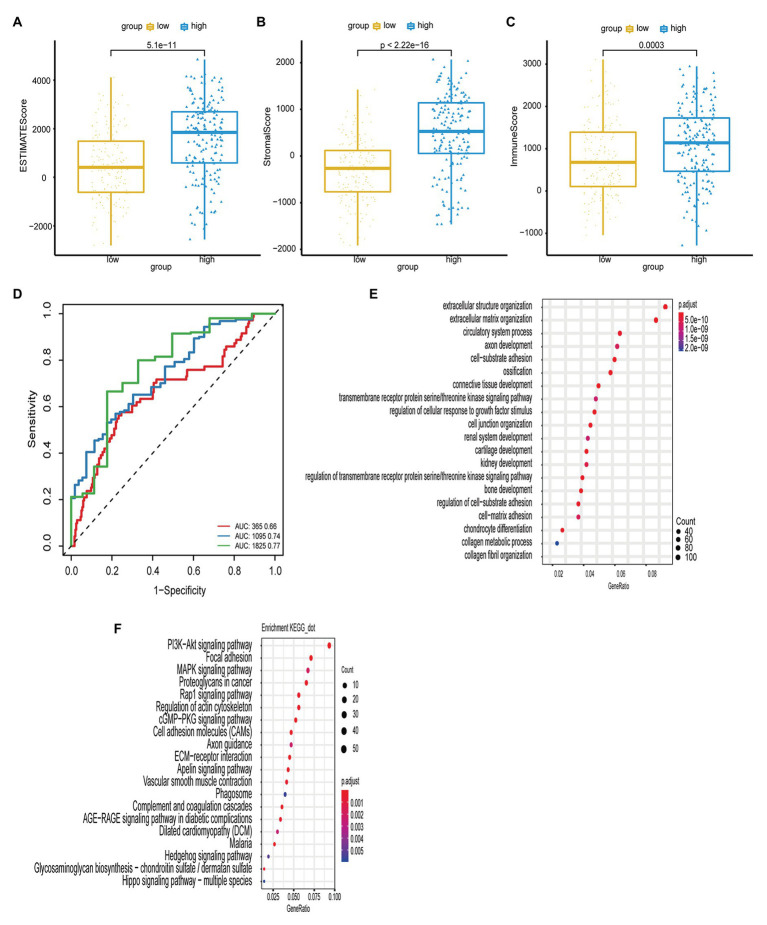
(A,B,C) The boxplot shows the infiltration distribution status of GC including ESTIMATE score, stromal score, immune score in the two groups of risk score. The immune scores between groups were tested by t-test. (D) The ROC curves of risk score model and multiple clinical traits (age, sex, TNM stage, clinical stage, and histological grade) for the prognostic accuracy of GC patients in 1, 3, and 5-year. (E,F) The bubble chart shows the result of GO and KEGG enrichment analysis of ARGs.